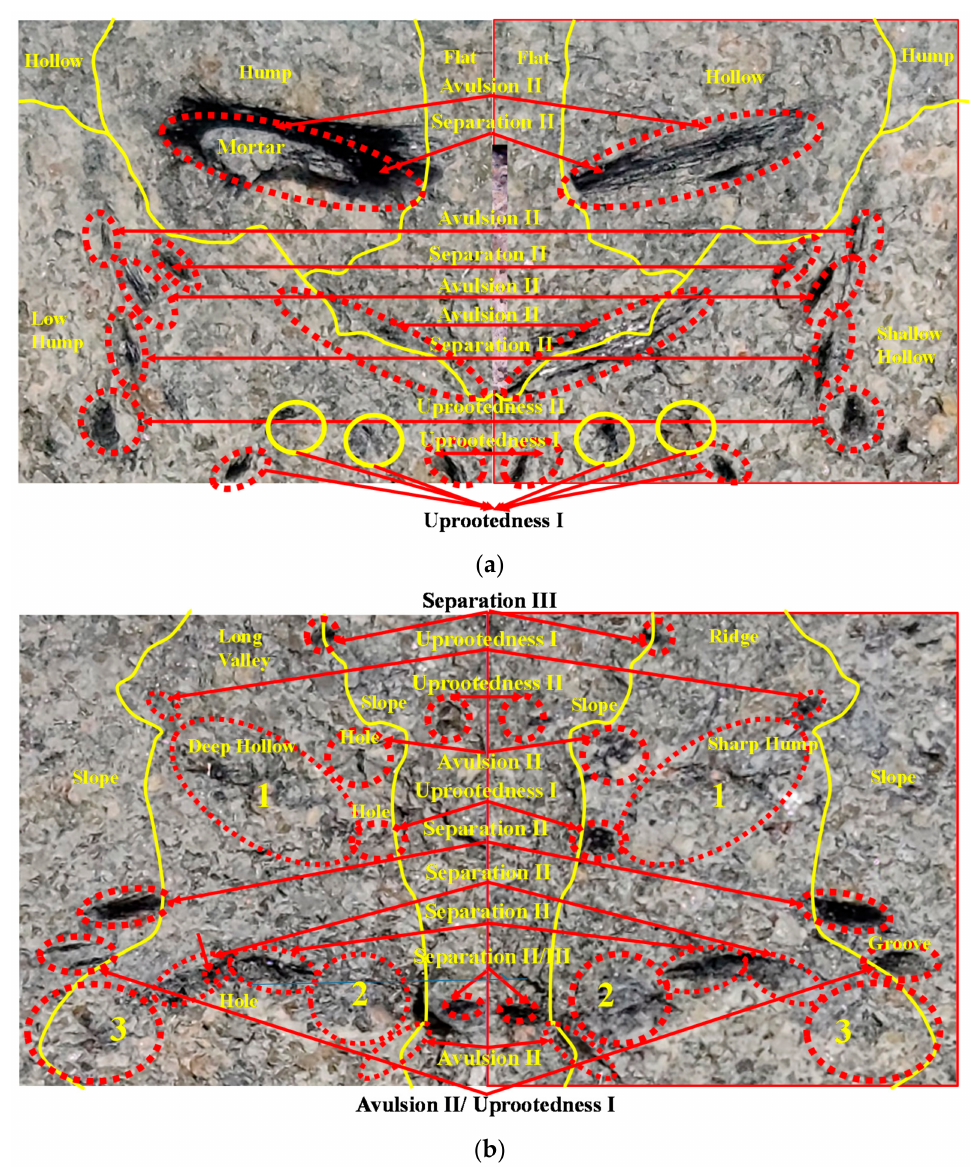
Figure 9. Fiber traces on the cracked surfaces of CF 1.0. ( a ) CF 1.0-1 ( b ) CF 1.0-2. The CF 1.0-1 is divided into four regions marked by solid lines; hollow (hump), hump (hollow), flat (flat) and low hump (shallow hollow) for the left (right) image. These hollow and hump couples indicate that there are three dividedness traces. The two couples on top are dividedness type I because no fibers are involved, except other traces. Both the